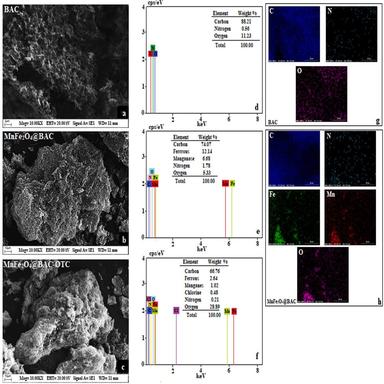
SEM images and EDX spectra of BAC, MnFe2O4@BAC before and after OTC sorption (a, b, c, d, e, f), and energy dispersive spectrometer element mapping of BAC and MnFe2O4@BAC (g, h).